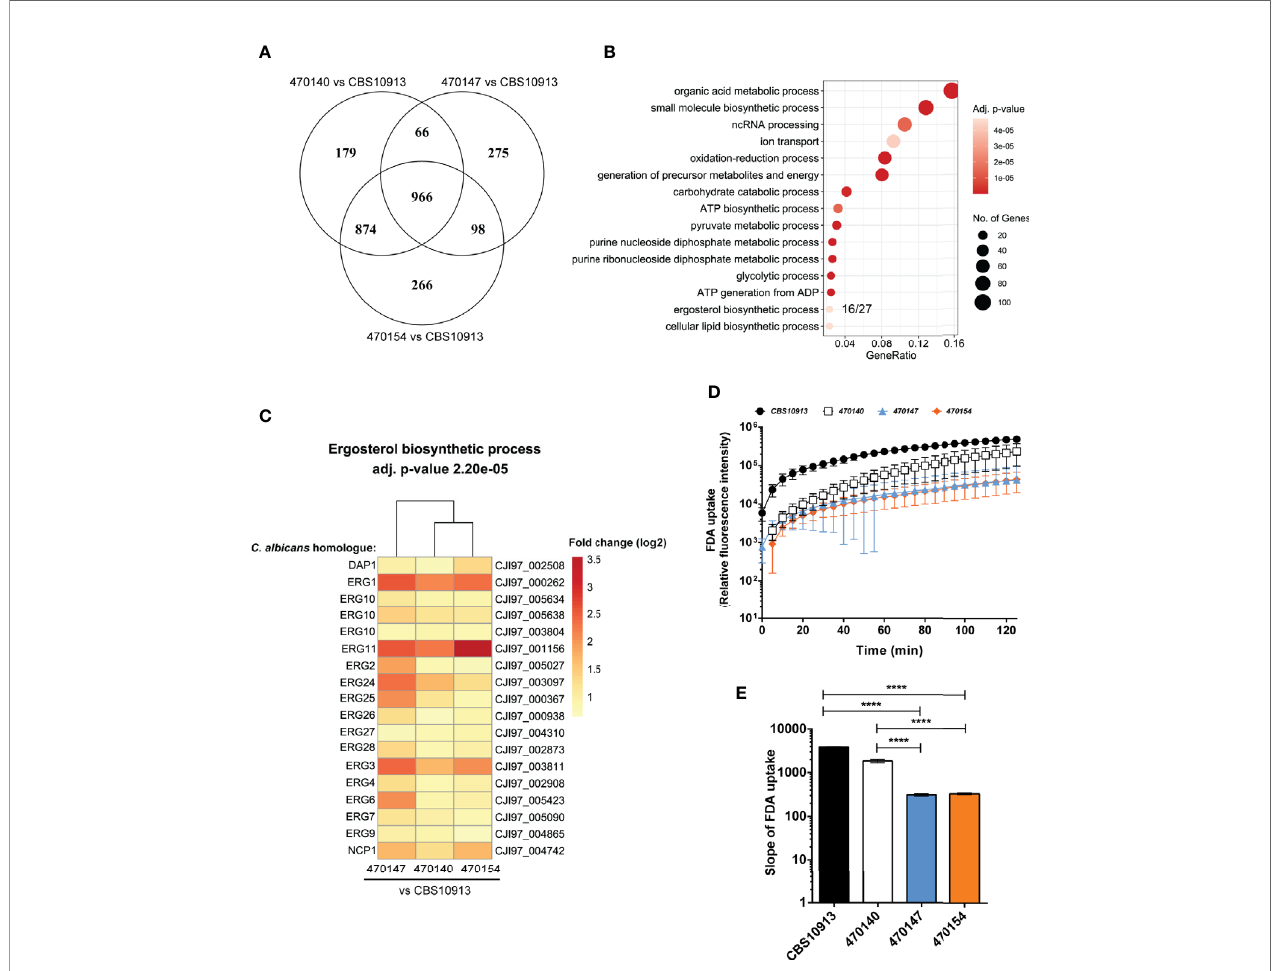
FIGURE 2 | Transcriptome analysis of C. auris clinical isolates. (A) Genome-wide transcript levels were determined for C. auris clinical isolates using RNA-seq. The number of differentially expressed genes (FDR < 0.05, fold change > 1.5 or < -1.5) and commonly regulated genes of pairwise comparisons are visualized. (B) GO- term enrichment analysis of commonly differentially expressed genes in clade I isolates relative to the CBS10913 type strain (intersection of the Venn diagram in panel (A) . The GeneRatio denotes the number or genes enriched in the depicted GO-term relative to the total number of genes associated with this GO-term. (C) Heatmap depicting genes enriched in the GO-term “ ergosterol biosynthetic process ” from panel (B) The color code indicates the fold-changes (log2) in gene expression. Gene names on the left side refer to C. albicans homologues as determined by BLASTp and labels on the right side depict C auris gene IDs. (D, E) Kinetics (D) and the slope (E) of FDA uptake by C. auris strains as indicated. Data represent mean + SD from 4 biological replicates. ****P < 0.0001 with one-way ANOVA and Tukey ’ s multiple comparison